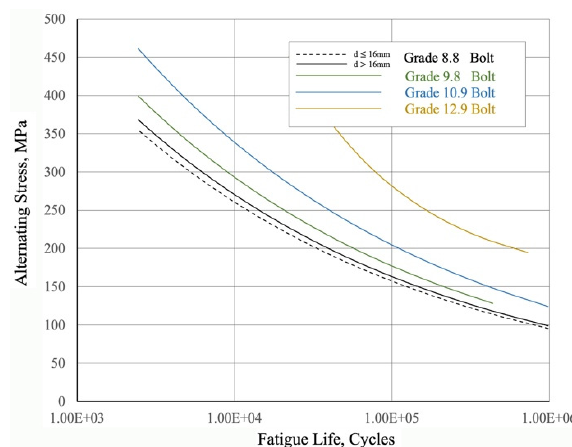
Figure 5. S-N curves for stress concentration K t = 4.97